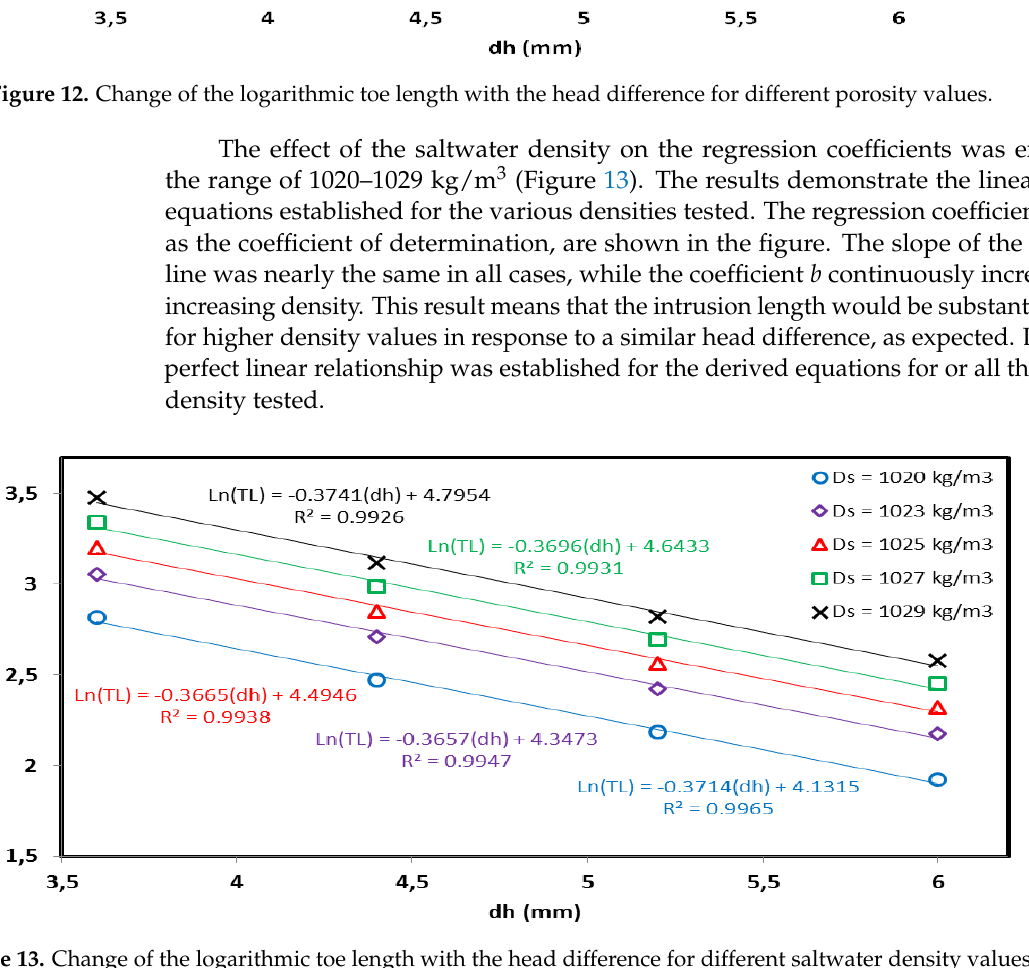
Figure 12. Change of the logarithmic toe length with the head difference for different porosity values.